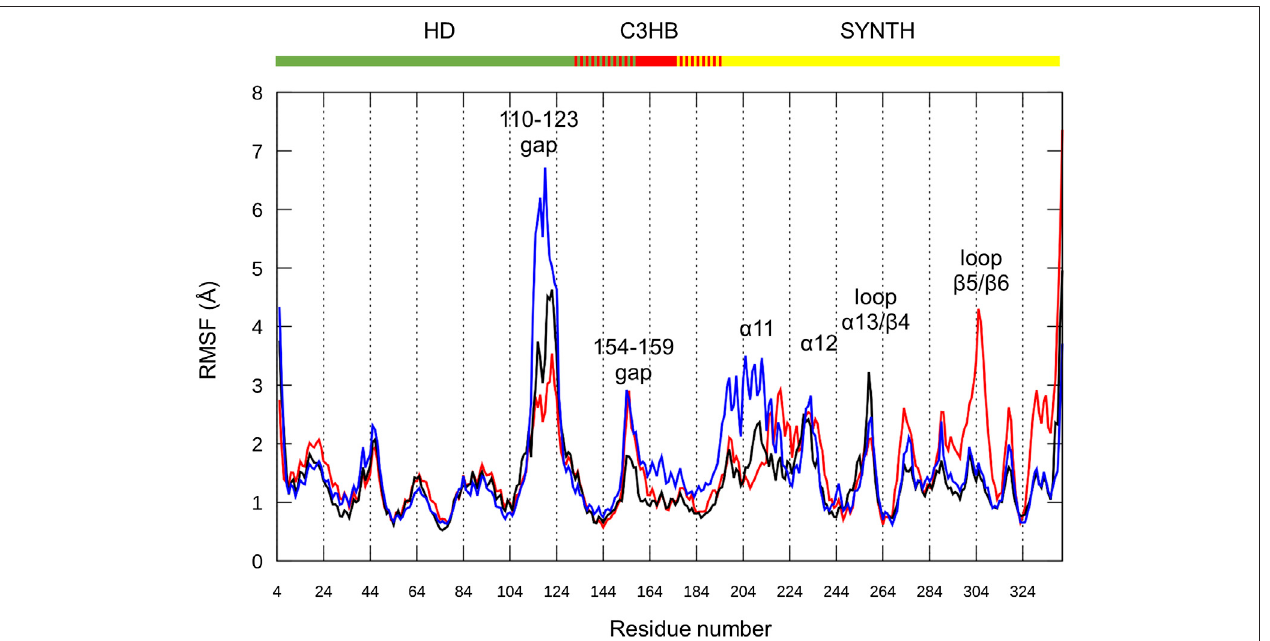
FIGURE6| Chimera fl uctuationanalysisovertheMDsimulationtime.RMSFcalculatedonproteinbackboneatoms(C,C α ,N,O,H)inthethreereplicas(#1red,#2 black, #3 blue) as a function of the residue number. HD (residues 5 – 159), C3HB (residues 135 – 195) and SYNTH (residues 176 – 341). Peaks with the highest RMSF values are labeled.